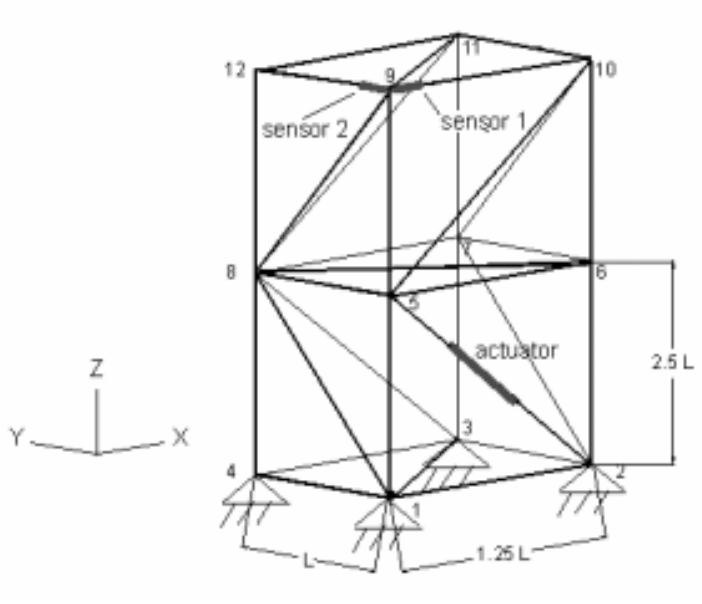
Fig. 1. Schematic of the truss structure showing the location of the actuator and sensors.